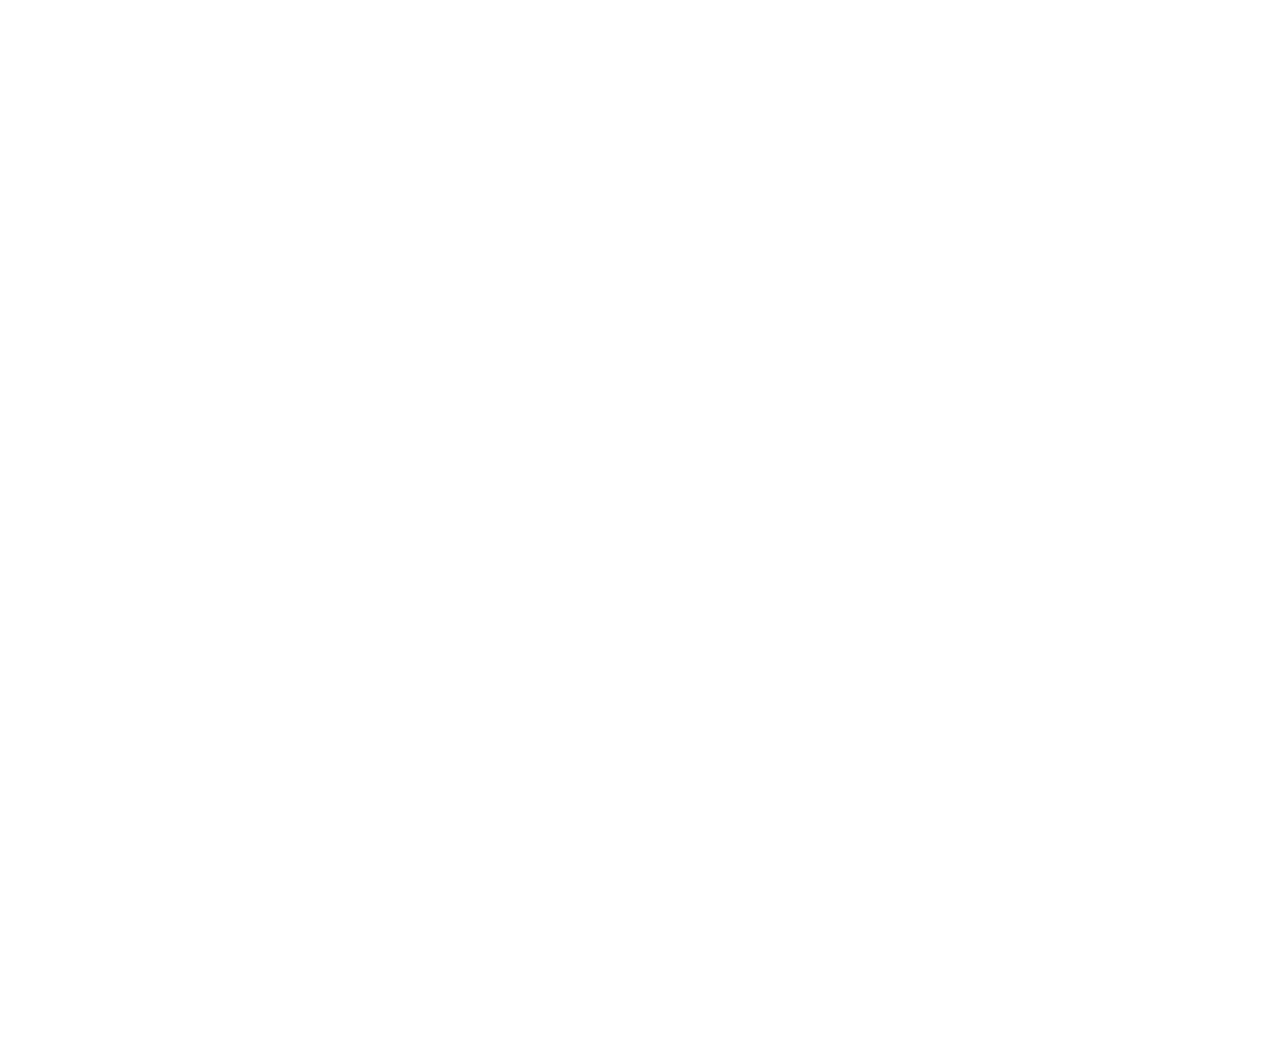
Frontiers in Plant Science | www.frontiersin.org